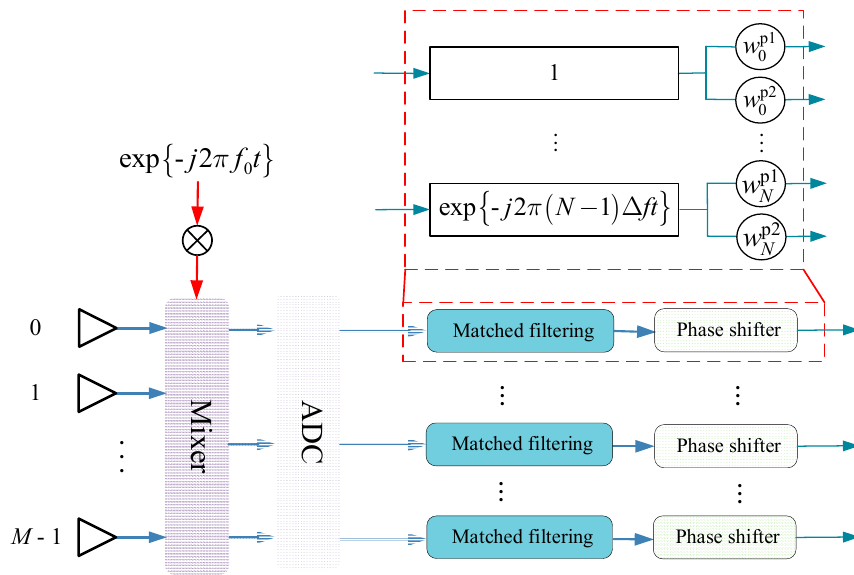
Figure 4. Receiver processing flow of the CMD method. Algorithm 2: Proposed CMD Algorithm.